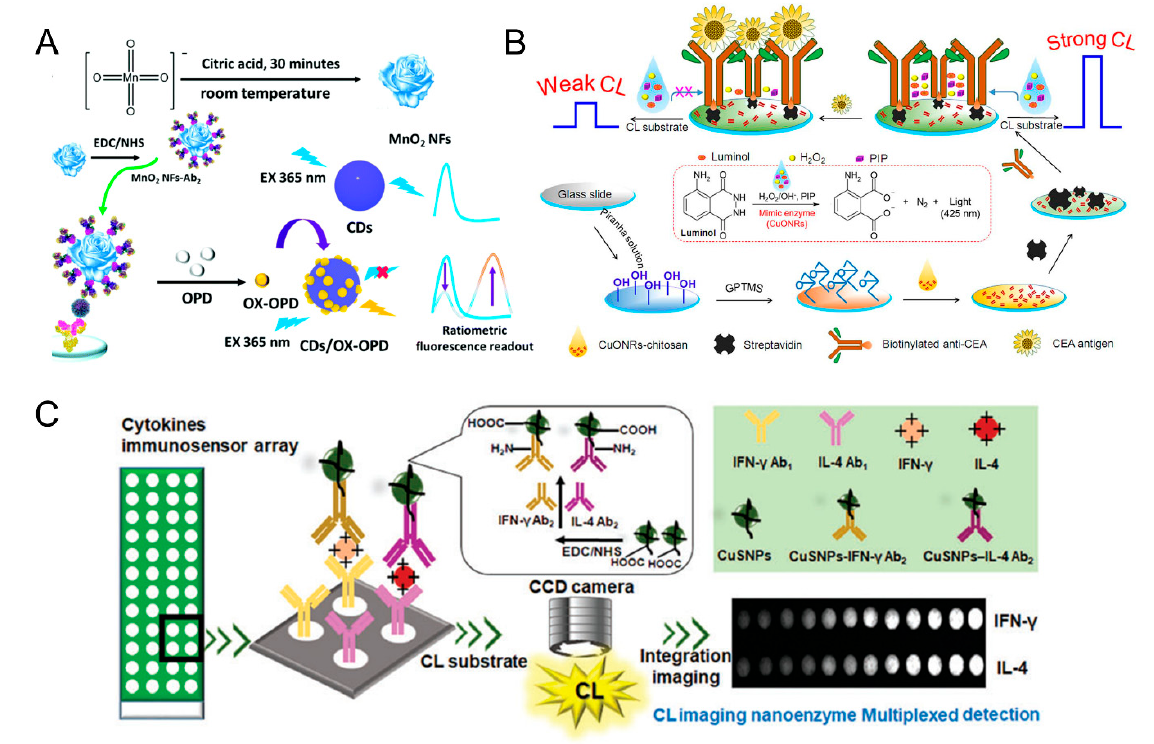
Figure 3. ( A ) Schematic diagram of a ratiometric fluorescence ELISA for CRP detection based on MnO2 NFs coupled with CDs [55]. Reprinted with permission from ref [55]. Copyright 2018 Royal Society of Chemistry. ( B ) Schematic illustration of the label-free nanozyme-based chemiluminescent immunosensor by using CuONRs for CEA detection [58]. Reprinted with permission from ref [58]. Copyright 2018 Elsevier. ( C ) Schematic illustration of CL imaging nanozyme immunoassay of mul- tiple chicken cytokines and an immunosensor array [60]. Reprinted with permission from ref [60]. Copyright 2018 Royal Society of Chemistry.